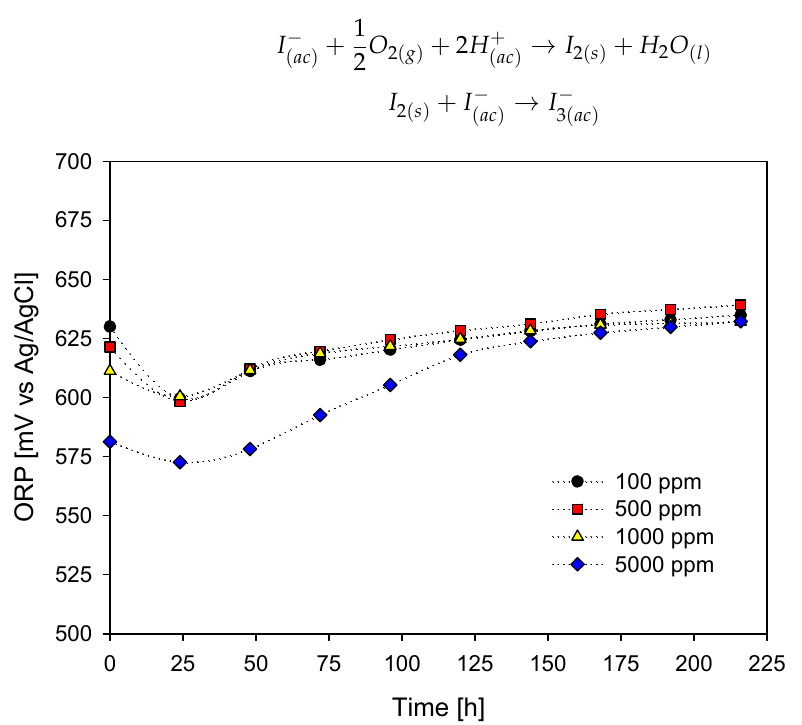
Figure 9. ORP effect vs time on metal extraction. [KI] = ( ) = 100 ppm; ( ■ ) = 500 ppm; ( ▲ ) = 1000 ppm; ( ) = 5000 ppm. [Conditions: H 2 SO 4 = 0.5 M, 45 °C, 50 g of sample in 1000 mL of seawater